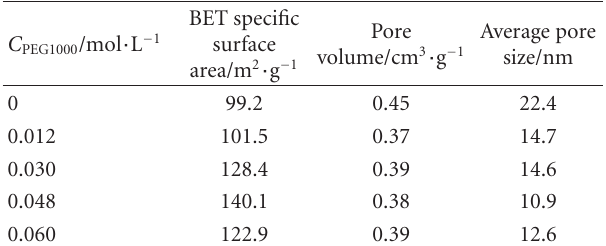
Table 1: BET specific surface area, pore volume, and pore size of mesoporous TiO 2 -Al 2 O 3 binary